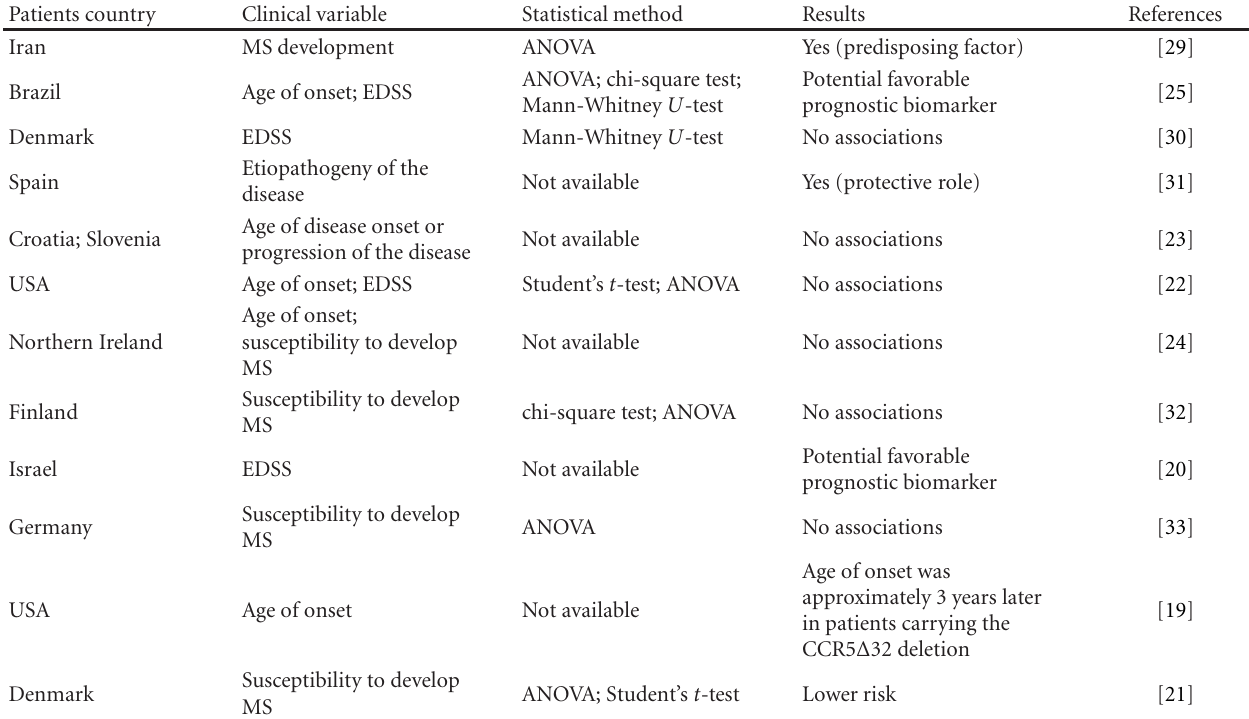
Table 3: Overview of major association